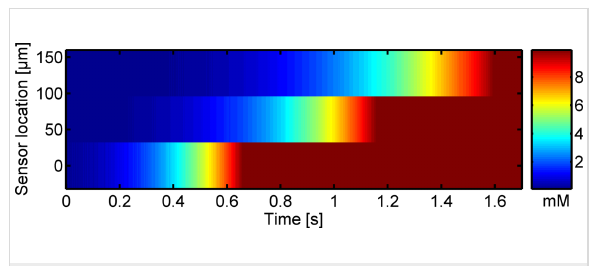
Figure 4: Electrochemical recording of the change in concentration during dissolution of a potassium haxacyanoferrate crystal above the sensor